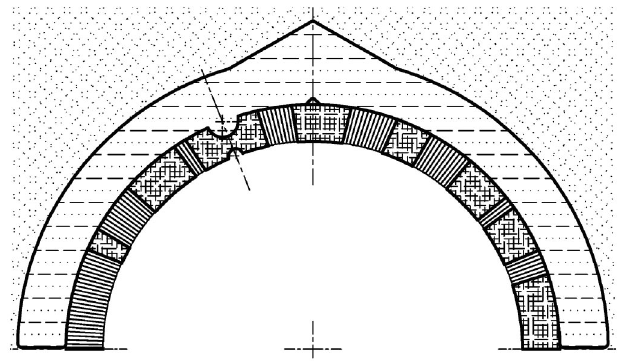
FIG. 38. Expanded view of the cross section of the super- conducting combined-function magnet used in the 50 GeV pro- ton beam line for the J-PARC neutrino experiment [31].